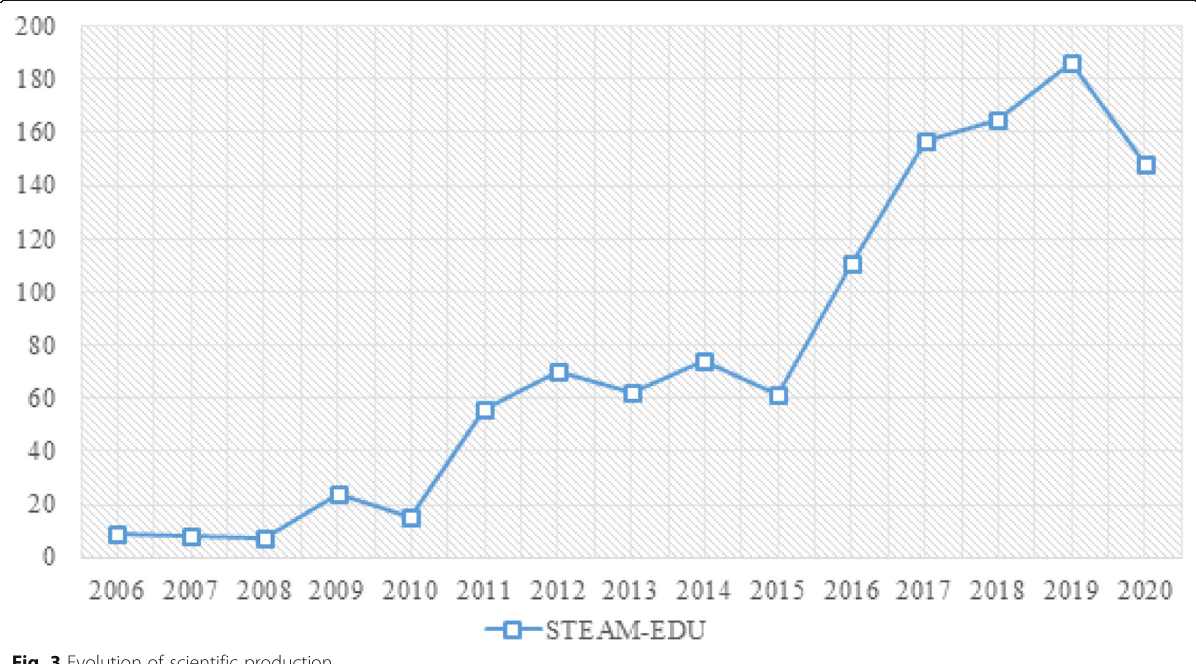
Fig. 3 Evolution of scientific production